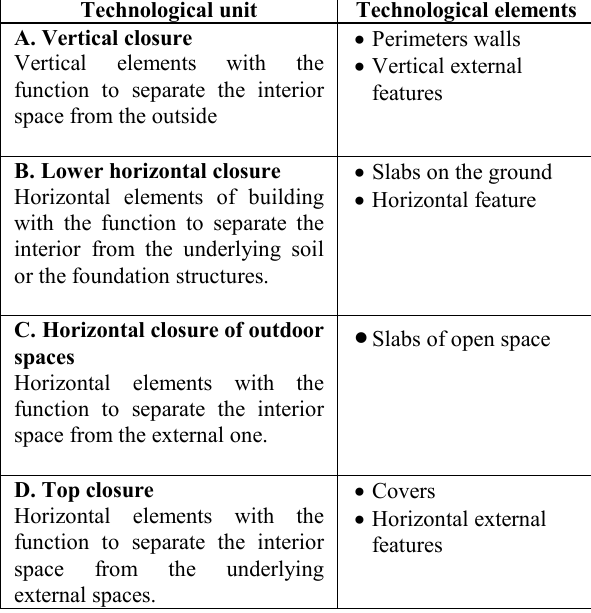
Table 1: The Technological System for the closings elements. The figure 5 shows the images of each